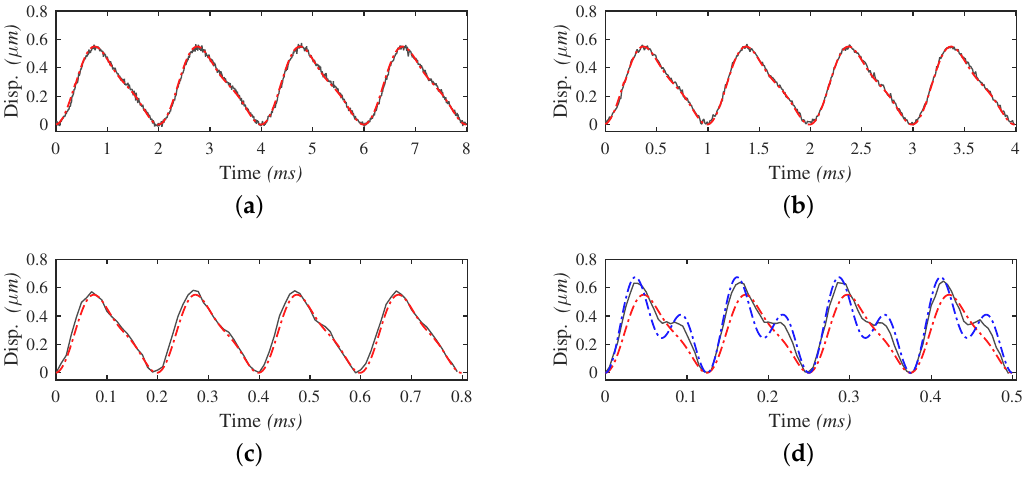
Figure 9. Input displacements with the LHW signals in different driving frequencies. The grey curves represent the actual input displacements of the pusher part, and the red curves represent the ideal input displacements driven by STW signals. The frequencies of the signals are: ( a ) 500 Hz; ( b ) 1000 Hz; ( c ) 5000 Hz; ( d ) 8000